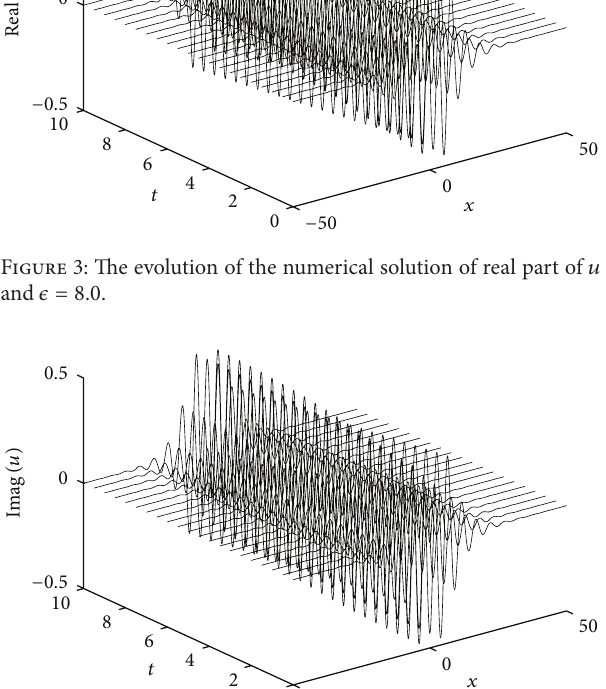
Figure 2: The evolution of the numerical solution of V with 𝜖 = 1.0 .